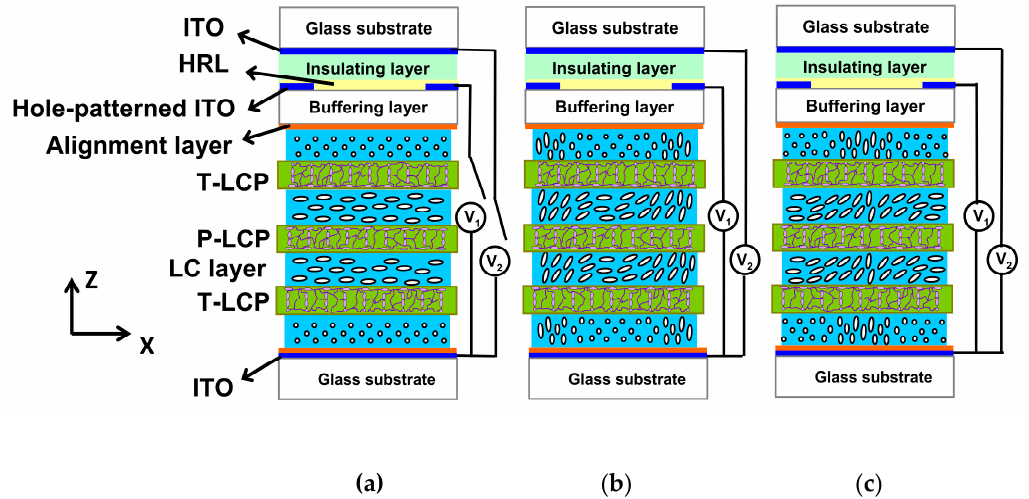
Figure 12. Schematic diagrams of the operation of the multilayered LC lens at ( a ) voltage-off state, ( b ) V 1 > V 2 and ( c ) V 2 > V 1 . © 2015 IEEE. Reprinted, with permission, from [179].